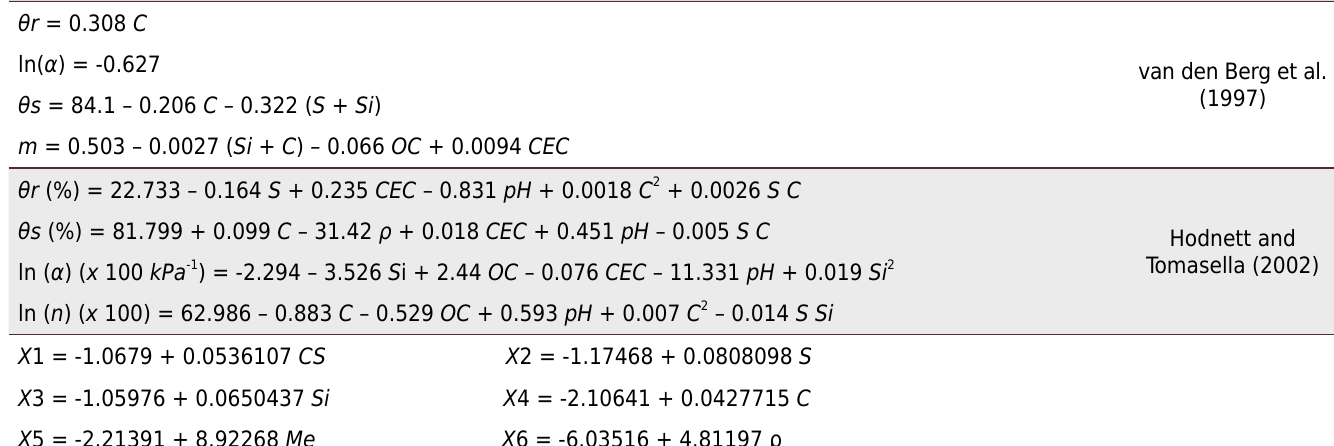
Table 2. Pedotransfer functions for tropical soils that were evaluated Pedotransfer functions for the h ( θ ) relations used in this study θr = 0.308 C ln( α ) = -0.627 θs = 84.1 – 0.206 C – 0.322 ( S + Si